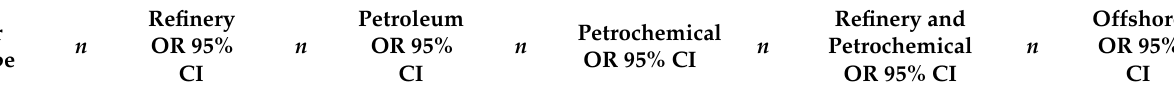
Table 3. Stratified/subgroup of cancer type by industry